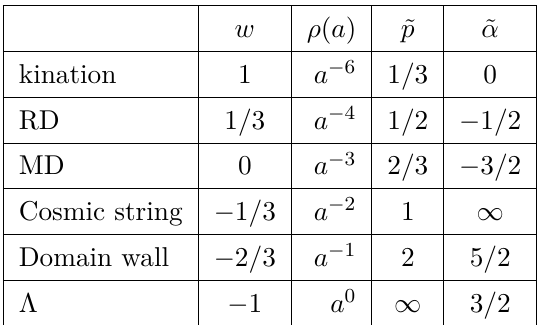
Table 1 . Examples of post-inflationary scenarios, the corresponding equation of state w , the evolu- tion of the energy density ρ ( a ) , and the corresponding ˜ p ( a ∝ t ˜ p ) parameter. For later convenience, we also define ˜ α = 3 / 2 + 1 / (˜ p − 1) . The last two rows correspond to accelerated expansion of the universe. However, in some scenarios, after inflation ends, the universe might still enter into a second stage of accelerated expansion period, e.g. the RD- t ˜ p -RD post inflationary